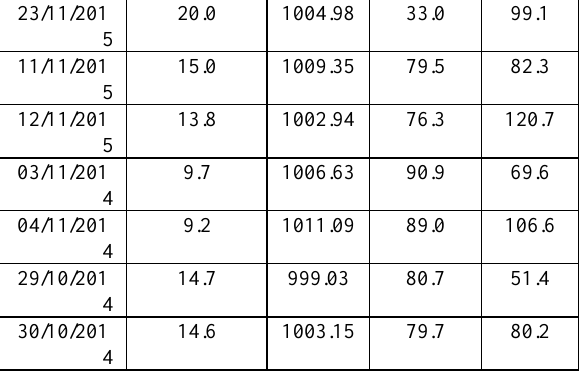
Table 2. Meteorological parameters of given days for PM10 comparison.